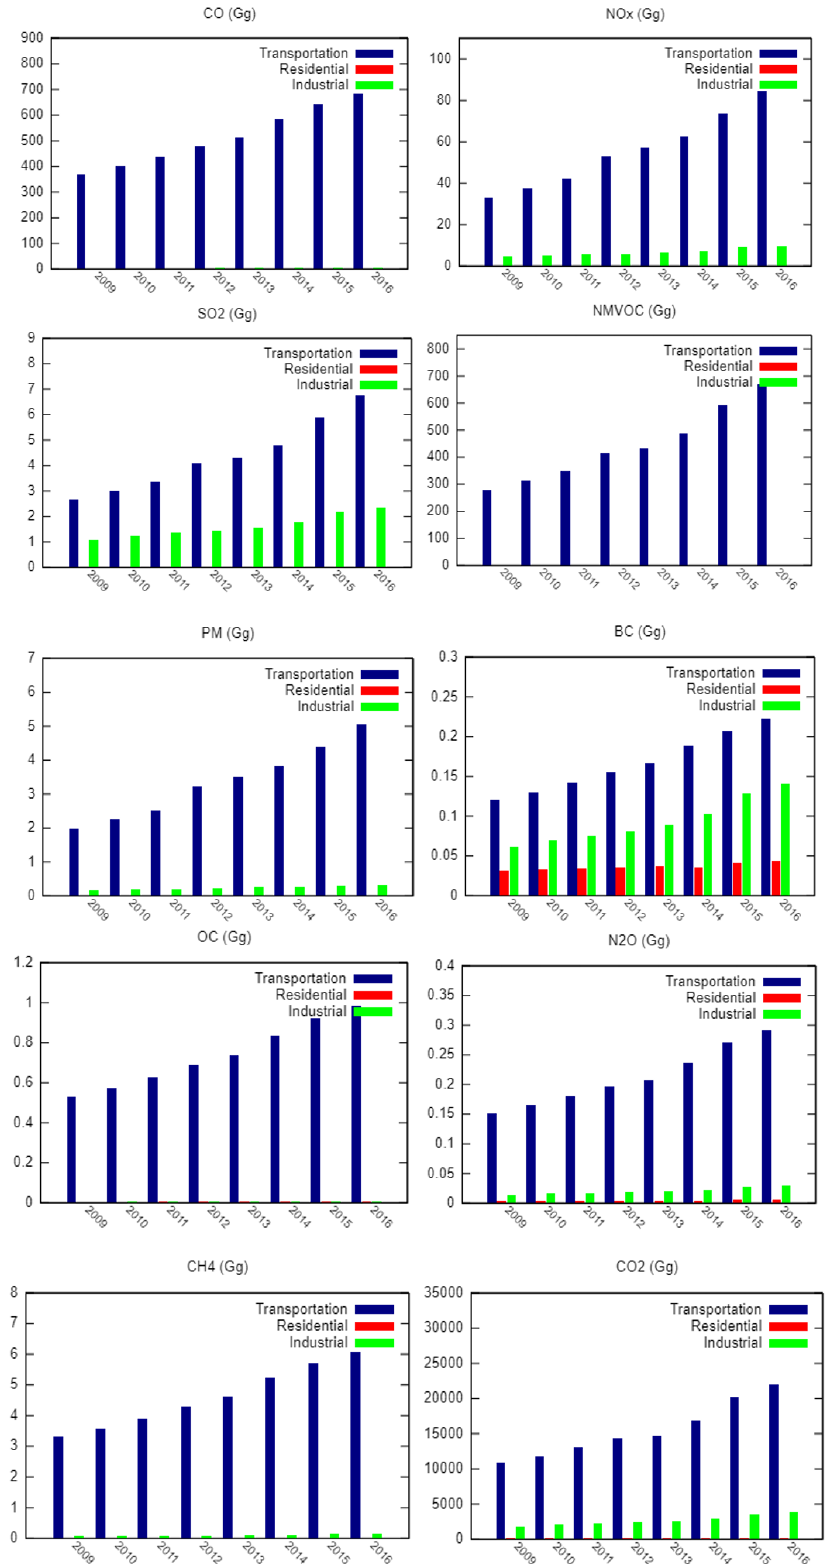
Figure 4. Annual emissions of each species in HCMC from 2009 to 2016 for three key sectors (unit: Gg).